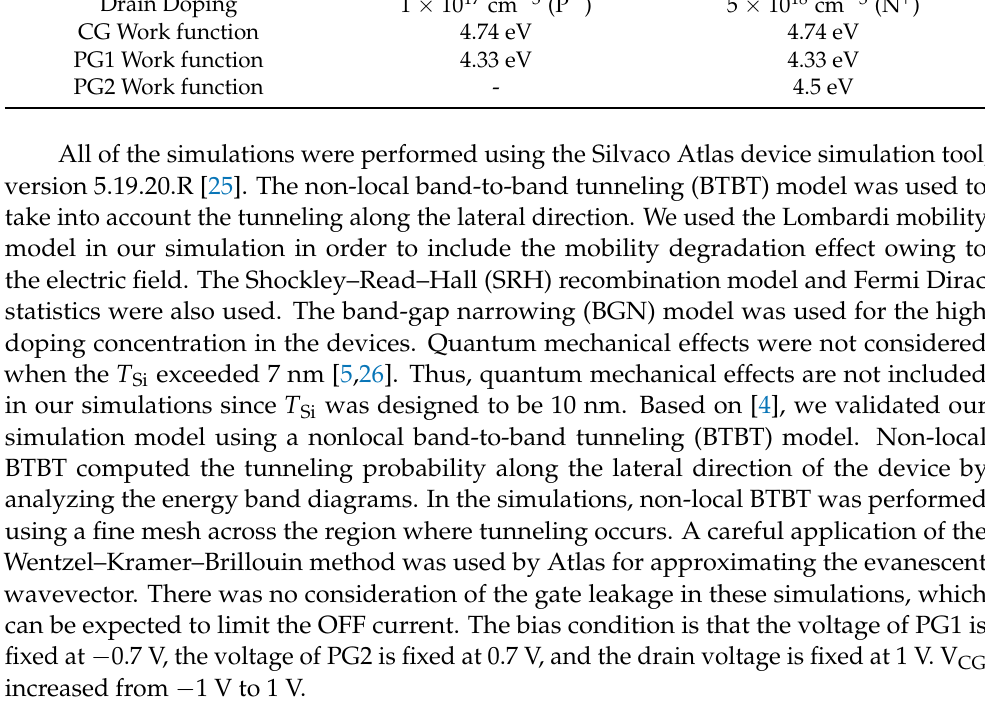
Table 2. Parameters used for device simulation. Conventional In-Built N + Parameter Pocket ED-TFET [19]